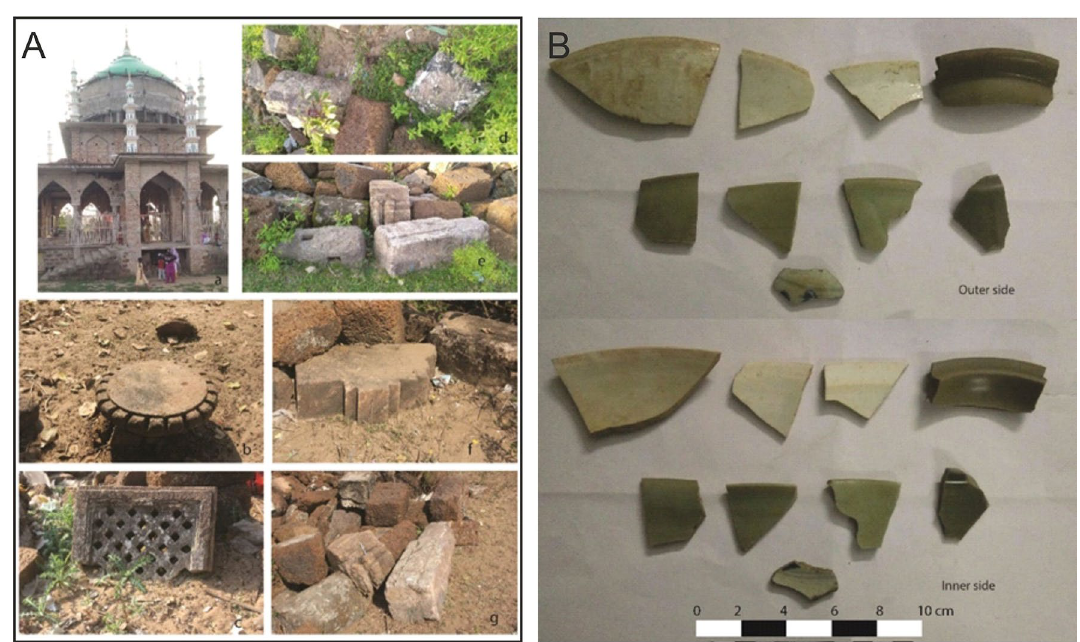
Figure 4. Architectural remains ( A ) and Chinese pottery found at Manikapatna, along with the stone anchor ( B